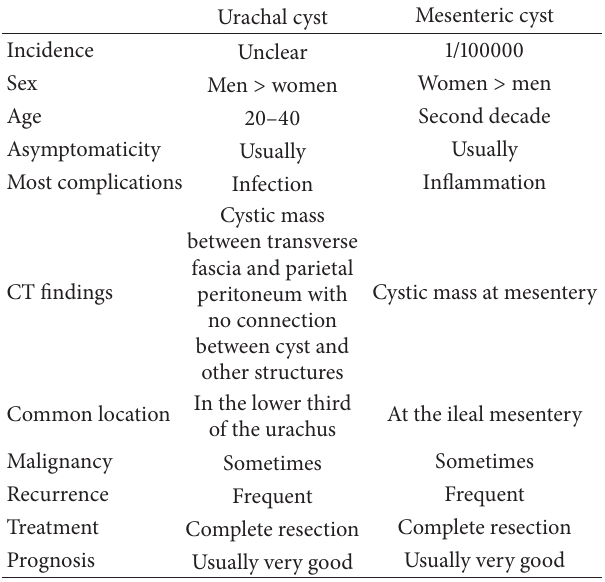
Table 1: Comparison of mesenteric cyst and urachal